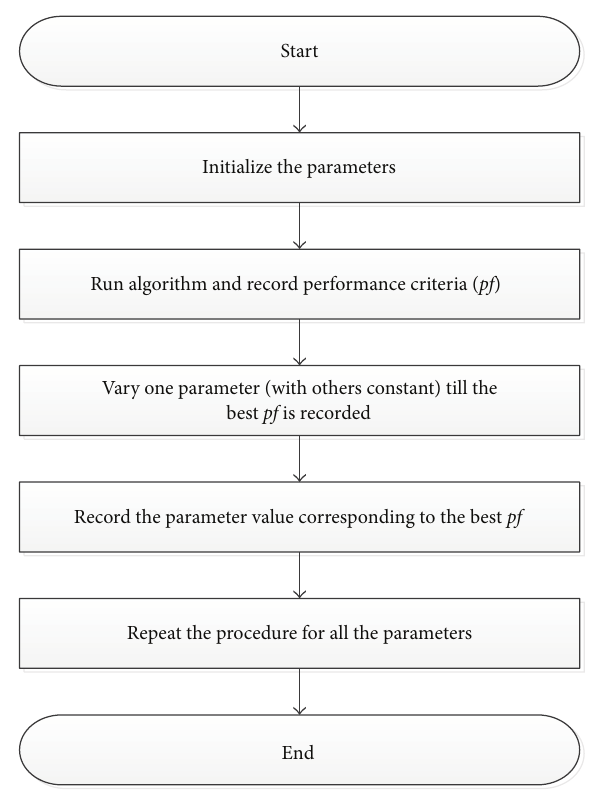
Figure 3: Test-set-validation